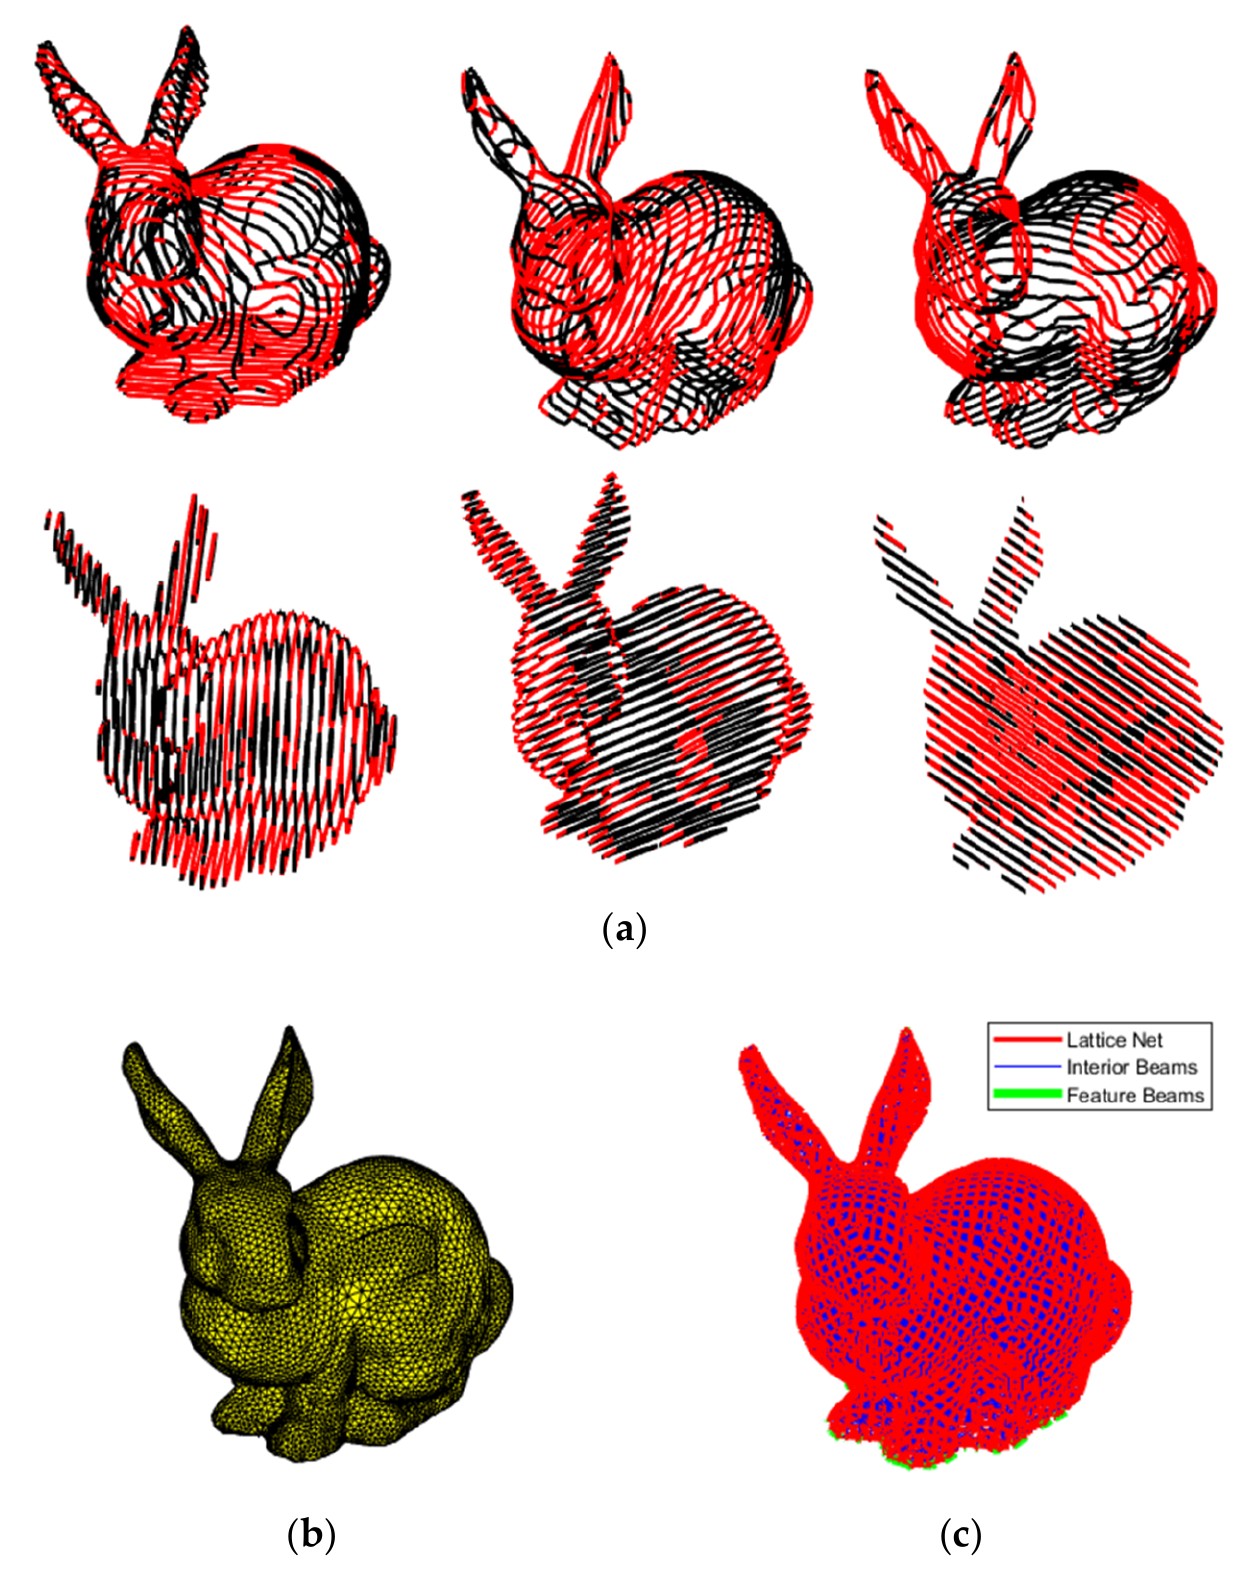
Figure 10. ( a ) Filtering of lattice net segments for each crystallographic plane of a BCC unit cell (Red = Accepted, Black = Rejected), ( b ) input mesh, and ( c ) final construction.